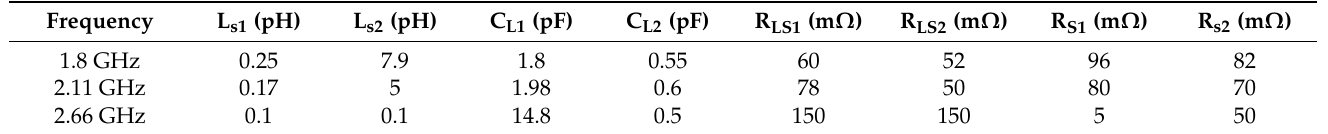
Figure 11. Practical rectenna circuit with all parasitic elements. Table 5. Values of the parasitic elements of the used inductors and capacitors for the three frequency bands.